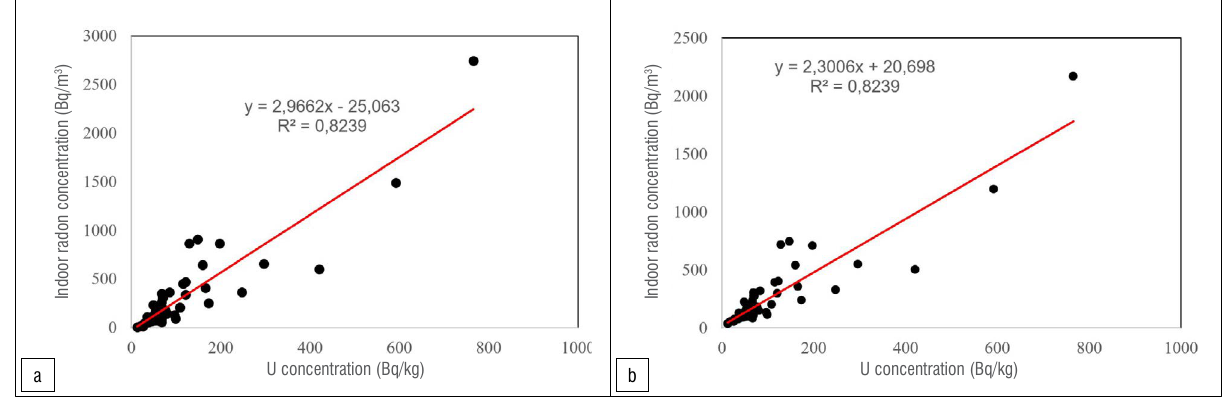
Figure 3: Indoor radon concentration as a function of uranium concentration in the Tusham Ring Complex of India. Indoor radon concentrations were (a) estimated from radon exhalation rates by means of the relationship identified from Figure 2 and (b) calculated from radon exhalation rates for the Tusham Ring